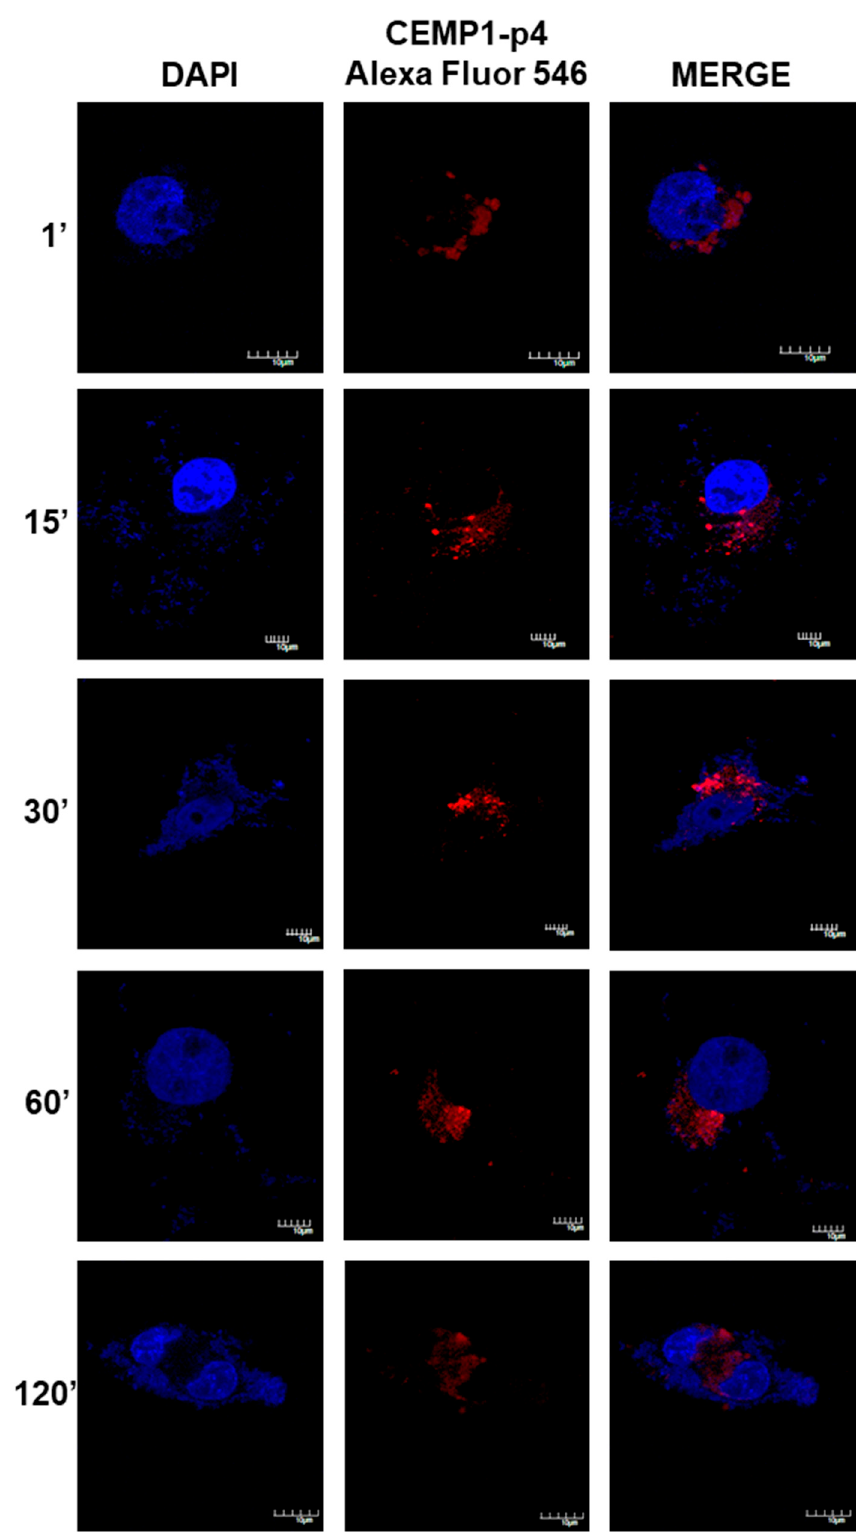
Figure 8. Confocal Microscopy Location of CEMP1-p4. CEMP-1-p4 labelled with Alexa Fluor 546 was mainly located surrounding the nucleus from the first minute and the pattern was diffuse and organized into granules and dispersed at 120 min. Original magnification, 3400. Scale bar = 10 μ m. 2.9. β -Catenin Translocation by CEMP1-p4